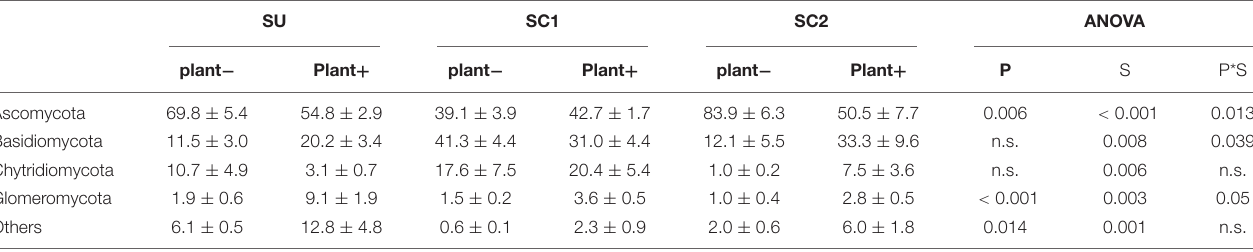
FIGURE 1 | Percentages of the relative abundance of dominant fungal and bacteria phyla in the two original composts (C1, C2) prior to soil application. Asterisks in the legend indicate differences in the relative abundance for each phylum between the two composts. TABLE 4 | Relative abundances (%) and standard errors of the most abundant fungal phyla in the three soils (SU, unamended soil; SC1, soil amended with compost 1; SC2, soil amended with compost 2), with (plant + ) or without (plant − ) olive sapling